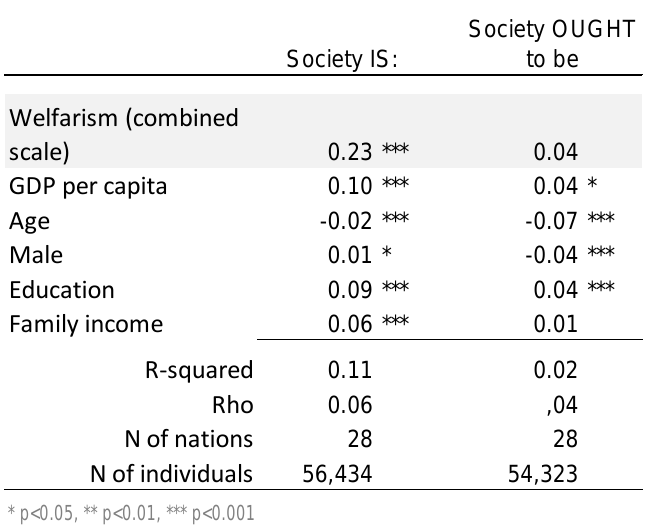
Figure 10. Demographic and SES differences in images of how egalitarian society is, and how egalitarian it ought to be, are small. Multilevel regression results; standardized coefficients. Sensitivity tests using alternative definitions of welfarism show the same pattern (Appendix D).